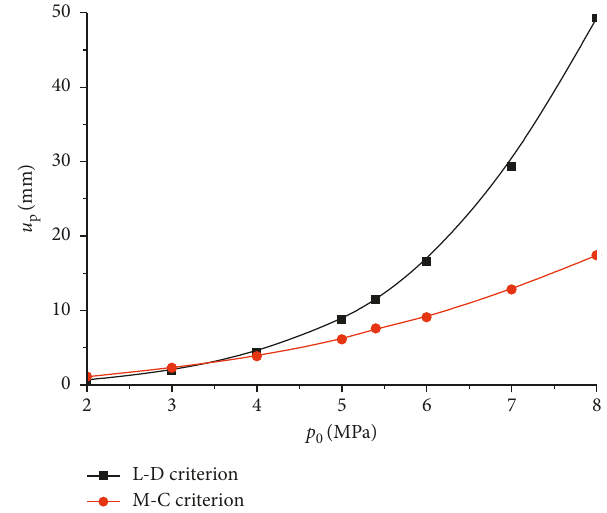
Figure 7: Relation curves between in situ stress and plastic zone